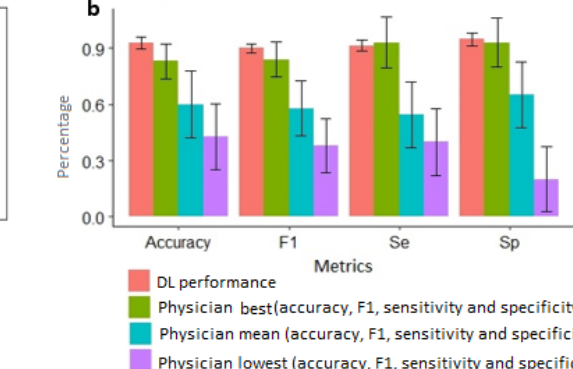
Figure 4. Physicians’performance for classifying electrocardiograms as correctly recording or as recording with V1 and V2 misplacement in the second intercostal space: (a) physicians’ performance and (b) comparison of deep learning performance with physicians' performance regarding different metrics. Error bars were derived using 95% CI (constant=1.96); the pale red bars represent the deep learning performance, whereas the other colors (green, light blue, and purple) represent the physicians’performance (best, mean, and lowest performance,